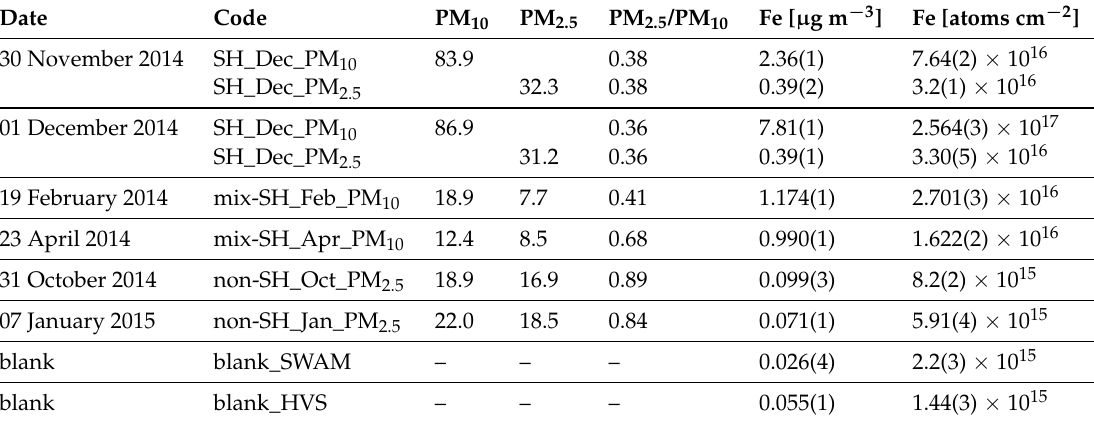
Table 1. Samples description: sampling date, filter code, aerosol mass concentration (PM 10 and PM 2.5 in µ g m − 3 ) and iron concentrations determined by ICP-OES for HVS (high volume sampler) PM 10